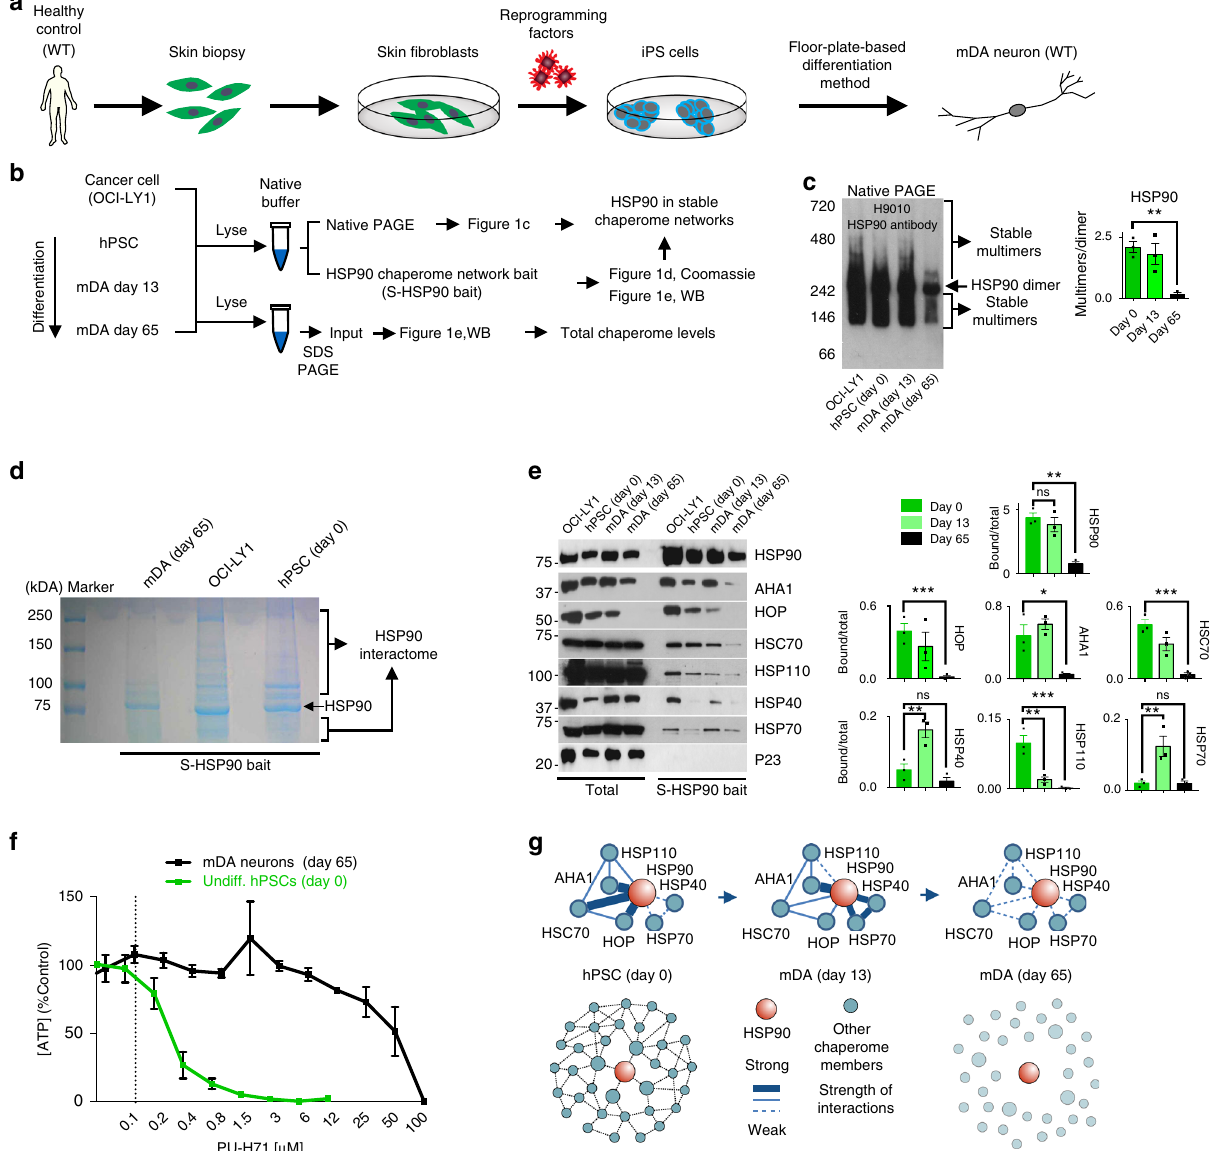
Fig. 1 HSP90 complexes in hPSCs and hPSC-derived mDA neurons. a , b Schematic illustration of the overall experimental design, showing pluripotent stem cells (PSCs) differentiation into midbrain dopaminergic (mDA) neurons ( a ) and the methods used to determine HSP90 incorporation into stable chaperome networks ( b ). c – e Native-PAGE ( c ), Coomassie stained denaturing gel ( d ) and western blots ( e ) comparing chaperome member levels in the whole cell lysate (Total) with those in S-HSP90 complexes (either af fi nity-puri fi ed, ( e ) or retained under native conditions ( c )) in: OCI-LY1 cancer cells, hPSCs (Day 0), hPSC-derived Day 13 precursors and hPSC-derived Day 65 mDA neurons. p23, pull-down speci fi city control. c , e Mean± SEM, n = 3 individual values from the different experiments shown as points, One-way ANOVA with Dunnett ’ s post-hoc, *** p < 0.001; ** p < 0.01; * p < 0.05; ns p > 0.05. f Viability of day 0 (hPSCs) versus day 65 mDA neurons in response to PU-H71 over 72 h. Dashed line, IC 50 for OCI-LY1 is shown for reference. Graph, means ± SEM of data from three or four independent experimental replications. g Summary schematic, showing the disassembly of stable HSP90 networks, characterized by enhanced interaction between HSP90 and participant chaperomes, as the process of neuronal differentiation progresses from the PSC stage to the mature, day 65 DA neuron